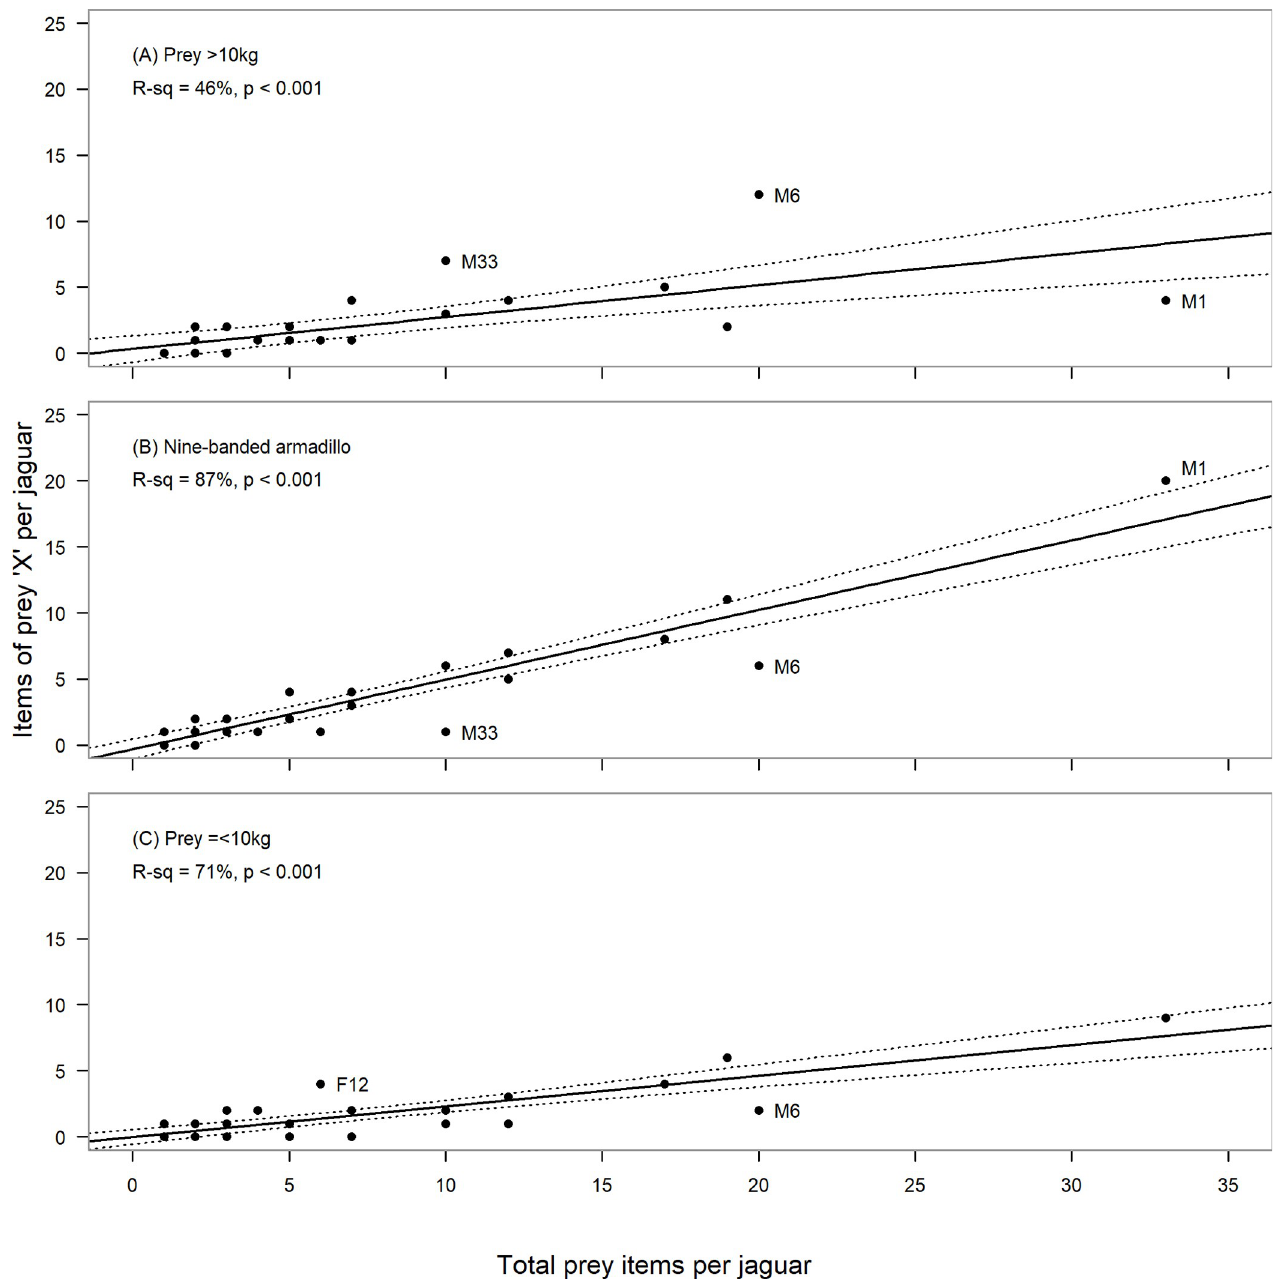
Fig 3. Variation in number of taxa ‘X’ items with sample size in diets of jaguars. Taxa X represents A) prey items > 10kg, specifically white-lipped peccaries, collared peccaries, red brocket deer, cattle, sheep and one dog, B) nine-banded armadillos, and C) other prey items � 10 kg, nine taxa. Each observation represents a unique jaguar sampled by collection of scats in the Cockscomb Basin Wildlife Sanctuary and neighbouring unprotected lands in Belize from 2003 to 2006 (30 jaguars, 200 independent prey items for which a weight class could be assigned; jaguars with large standardised residuals ( > 2) are labelled, M = male, F = female); 95CI shown as dotted